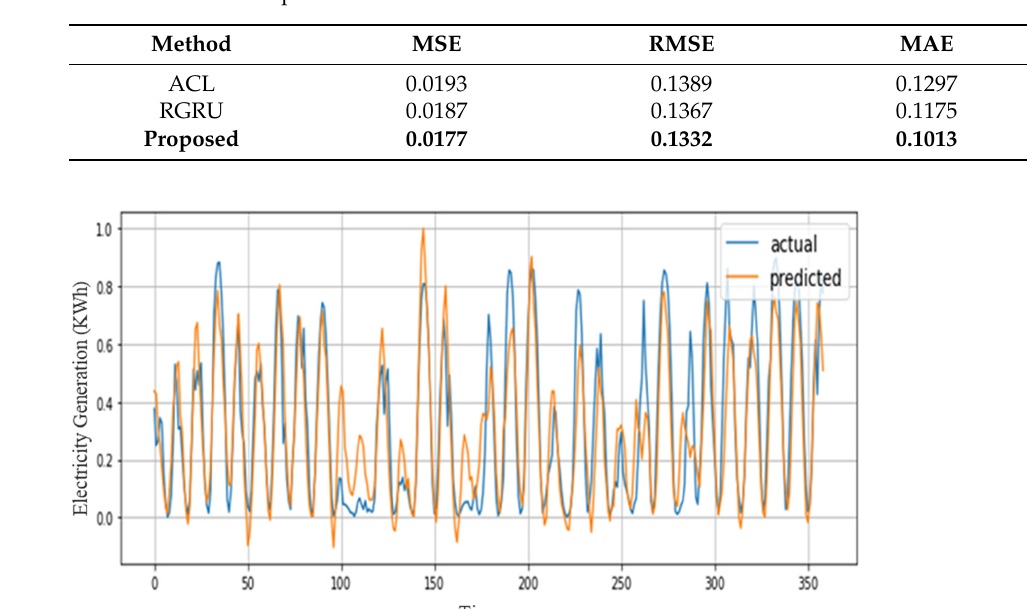
Table 5. Various models performance over the solar dataset using hourly resolution data. Bold results demonstrate the best performance.